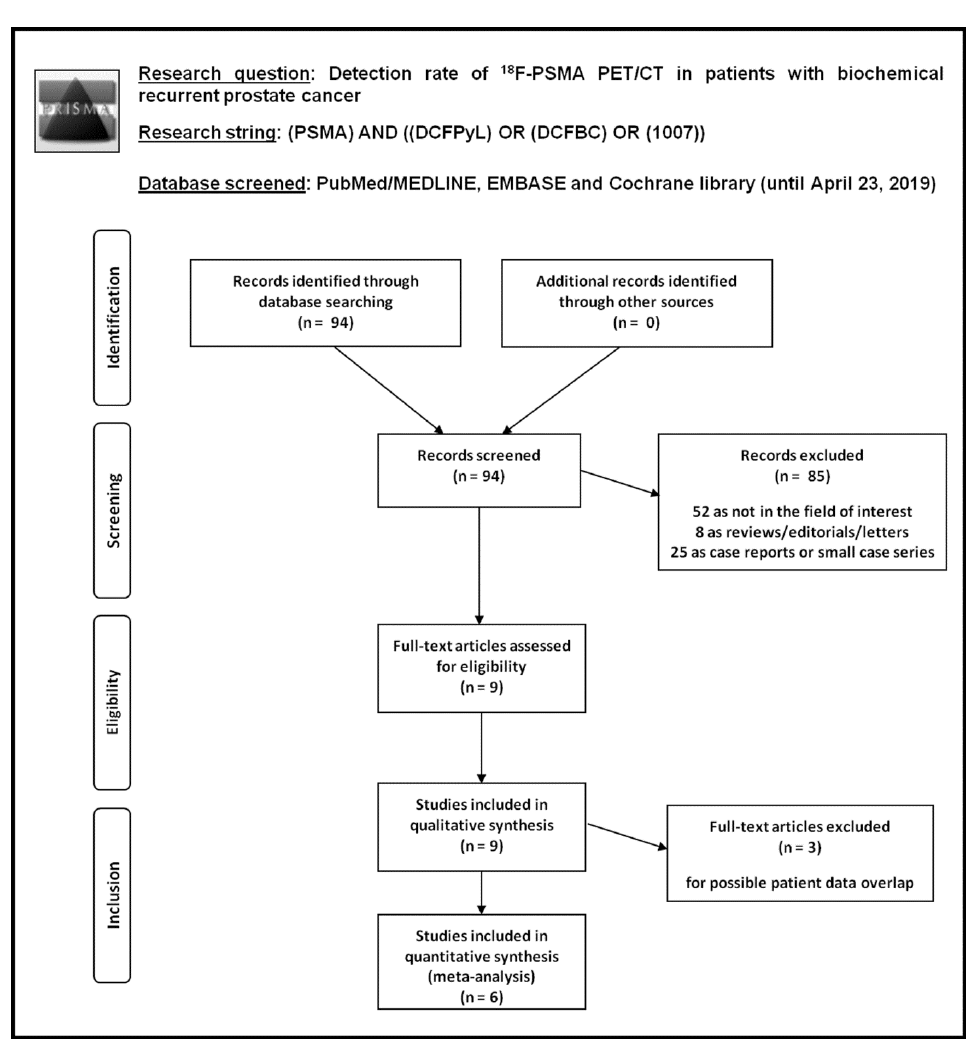
Figure 1. Flow chart of the search for eligible studies on the detection rate of 18 F-PSMA PET/CT in patients with biochemical recurrent prostate cancer.